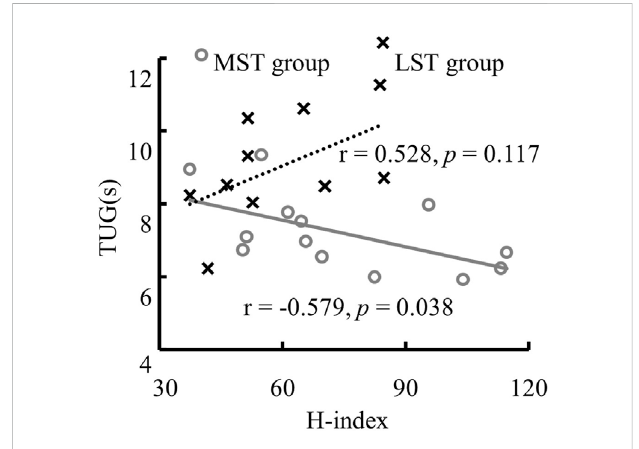
FIGURE 6 The signi fi cant linear relationship between TUG and the H-index of MG in the MST